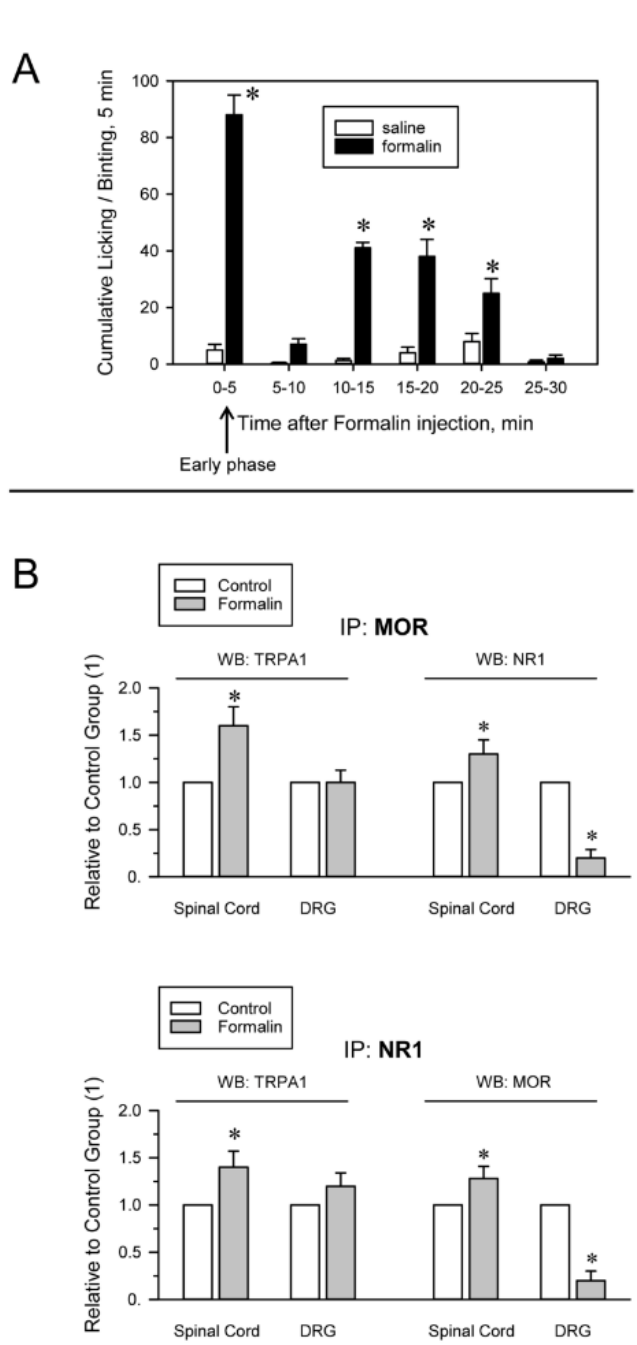
Figure 3. Formalin-induced inflammatory pain alters TRPA1 associations with MORs and NMDARs. ( A ) The mice received at time 0 an intraplantar injection of saline (control group) or 20 µ L of a 0.5% formalin solution into one of the hind paws. The time spent licking/biting was recorded every 5 min by a blinded observer. The bars are the mean ± SEM from three determinations. * Indicates significant difference compared to the saline control group, p < 0.05. ( B ) The animals were sacrificed 5 min after the injection, when the early phase of formalin-induced pain had already peaked (indicated by the arrow). DRG and spinal cords were obtained. MORs and NR1 subunits were immunoprecipitated from the solubilized membrane preparations. At the end of the procedure, coprecipitated TRPA1 was detached from the bait proteins and analyzed by Western blotting * Indicates significant difference compared to the saline control group, p < 0.05. Further details in Figure 2, Supplementary Materials Figure S5 and Section